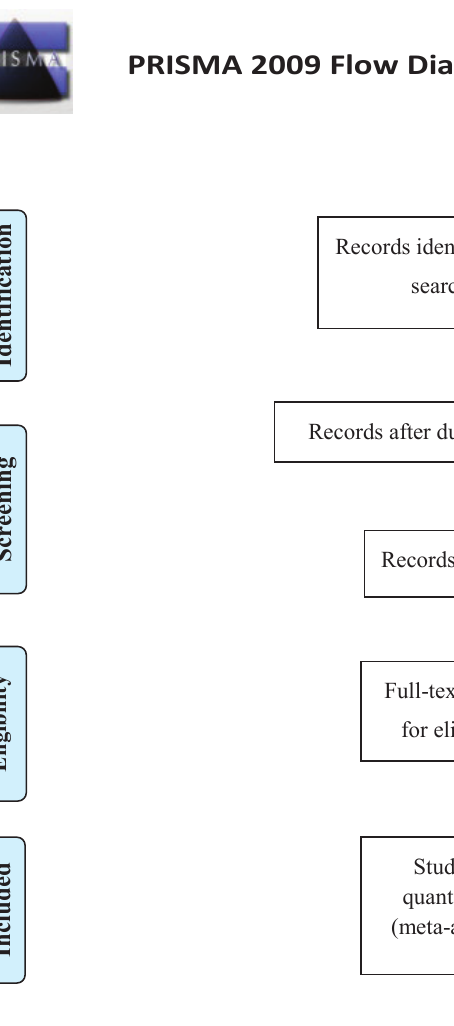
Figure 1: Flow diagram of included and excluded studies.